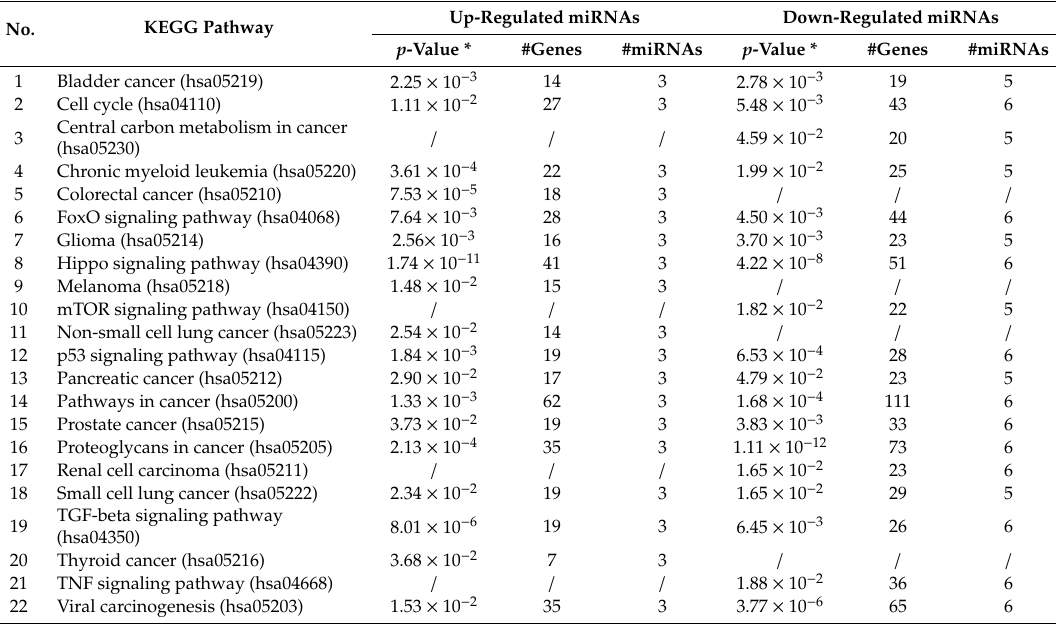
Table 4. Pathways involved in neoplastic transformation and modulated by the 11 computationally selected